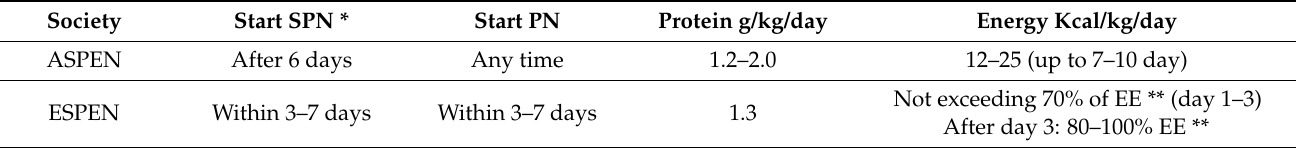
Table 5. ASPEN and ESPEN recommendations for critically ill patients with